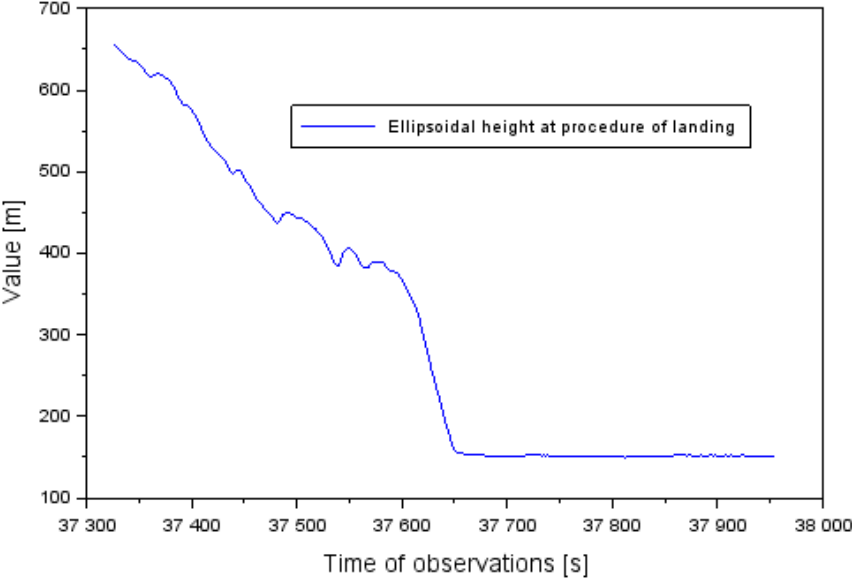
Figure 1. The vertical profile of Cessna 172 aircraft at landing procedure at the D ę blin aerodrome.